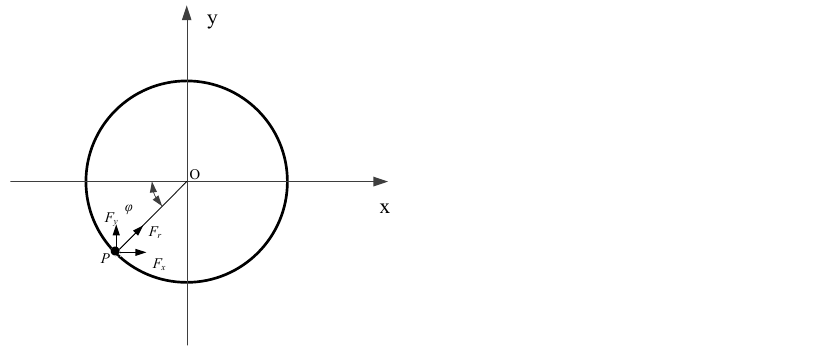
Coatings 2023 , 11 , x FOR PEER REVIEW Figure 9. Deformation force measured by experiment 2. Figure 9. Deformation force measured by experiment 2. Figure 9. Deformation force measured by experiment 2.